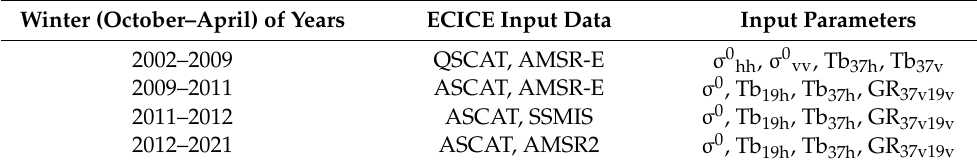
Table 1. Information of the active and passive microwave observations input to ECICE for differ- ent